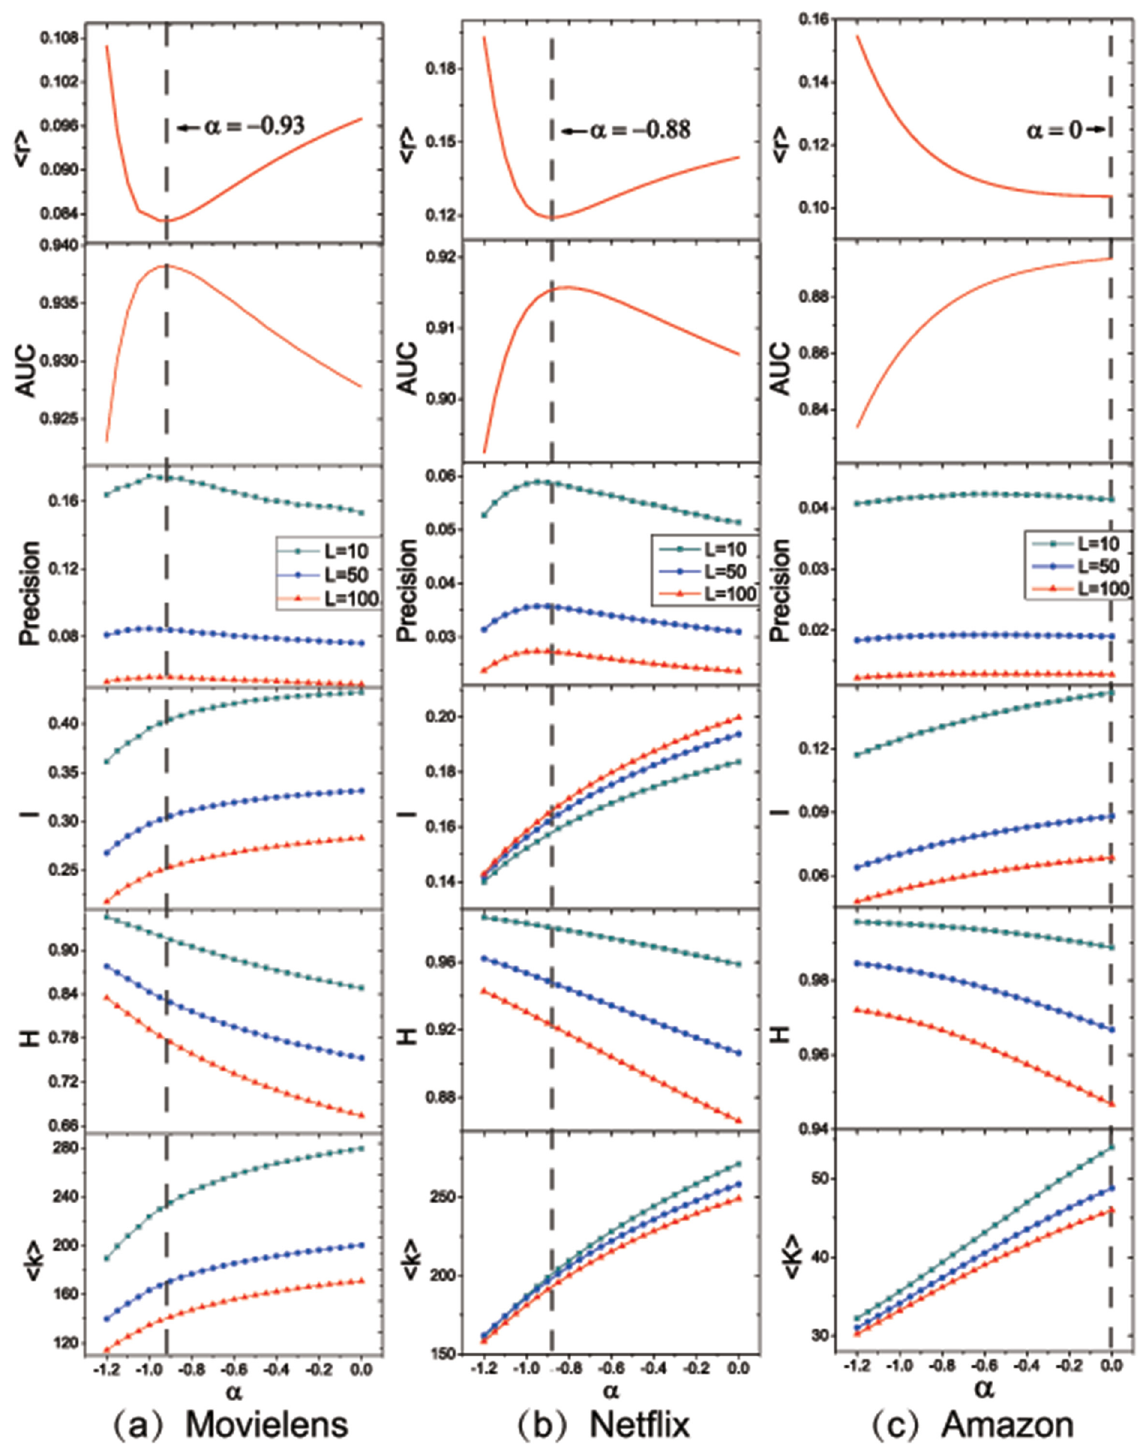
Fig 3. Demonstration of performances of CRE under optimal parameter ( α = -0.93 in Movielens, -0.88 in Netflix and 0 in Amazon, from the left to the right) of lowest ranking score, with L = 10, 50 and 100. From the top to the bottom, the subgraphs exhibit ranking score, AUC, precision, intra-similarity, hammingdistanceand averagedegreein the parameter range [-1.2, 0], to confirm the performancepromotion under depressing similarity redundancy,regardlessof the recommendationlist’s length L.